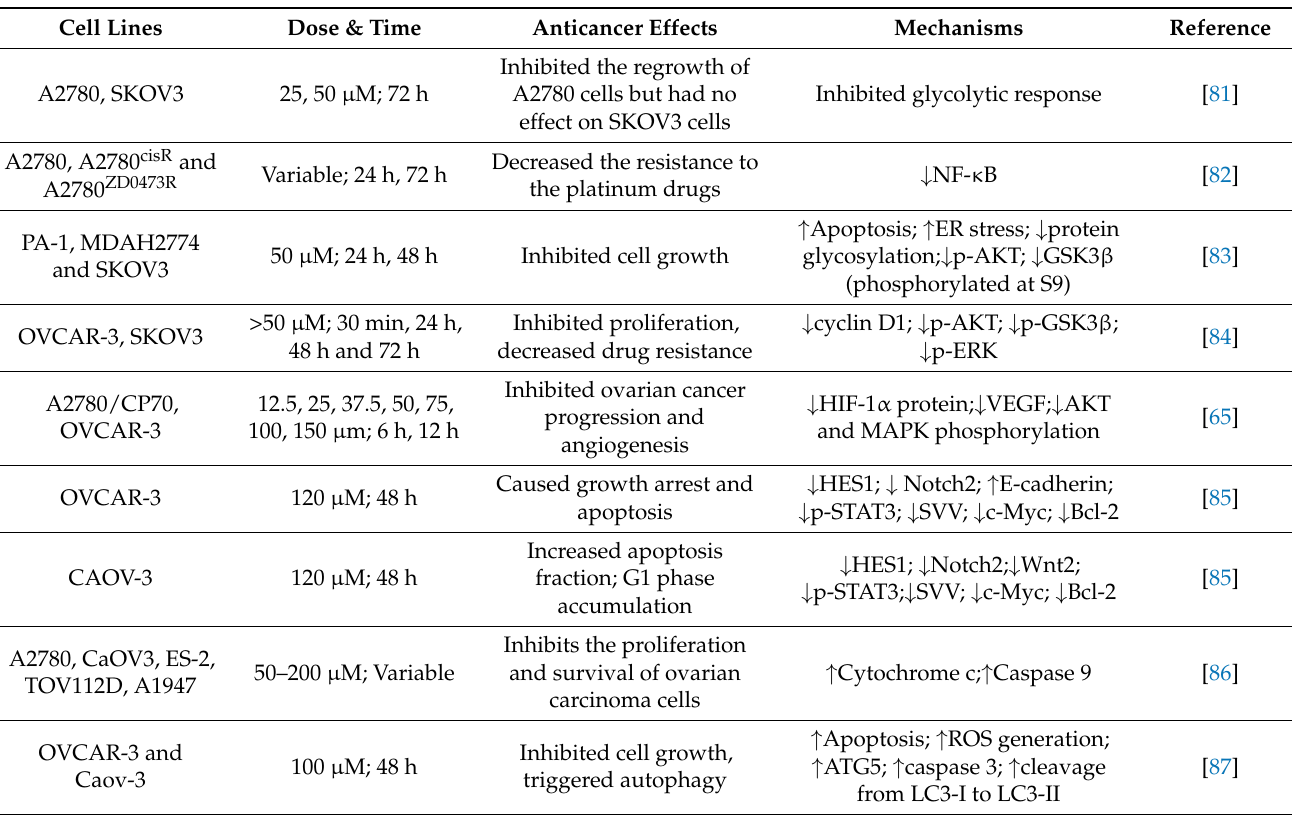
Table 2. The antitumor effect and mechanisms of action of resveratrol in ovarian cancer. Cell